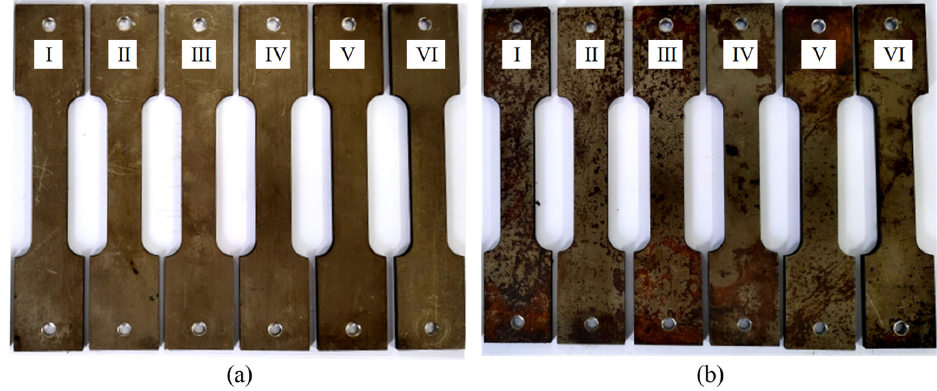
Figure 2. Tensile test sample. ( a ) 316L; ( b ) Q235B. Figure 3a,b show the real flow stress–strain curves of the 316L and Q235B obtained by Gleeble high temperature tensile tests at different temperatures. As can be seen from Figure 3, the flow stress of the 316L and Q235B increased with the increase in flow strain and decreased with the increase in temperature.